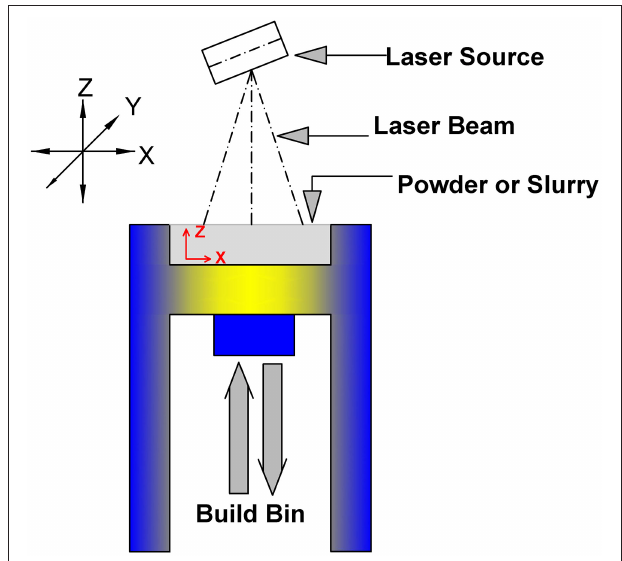
FIGURE 3 | Selective Laser Sintering diagram.